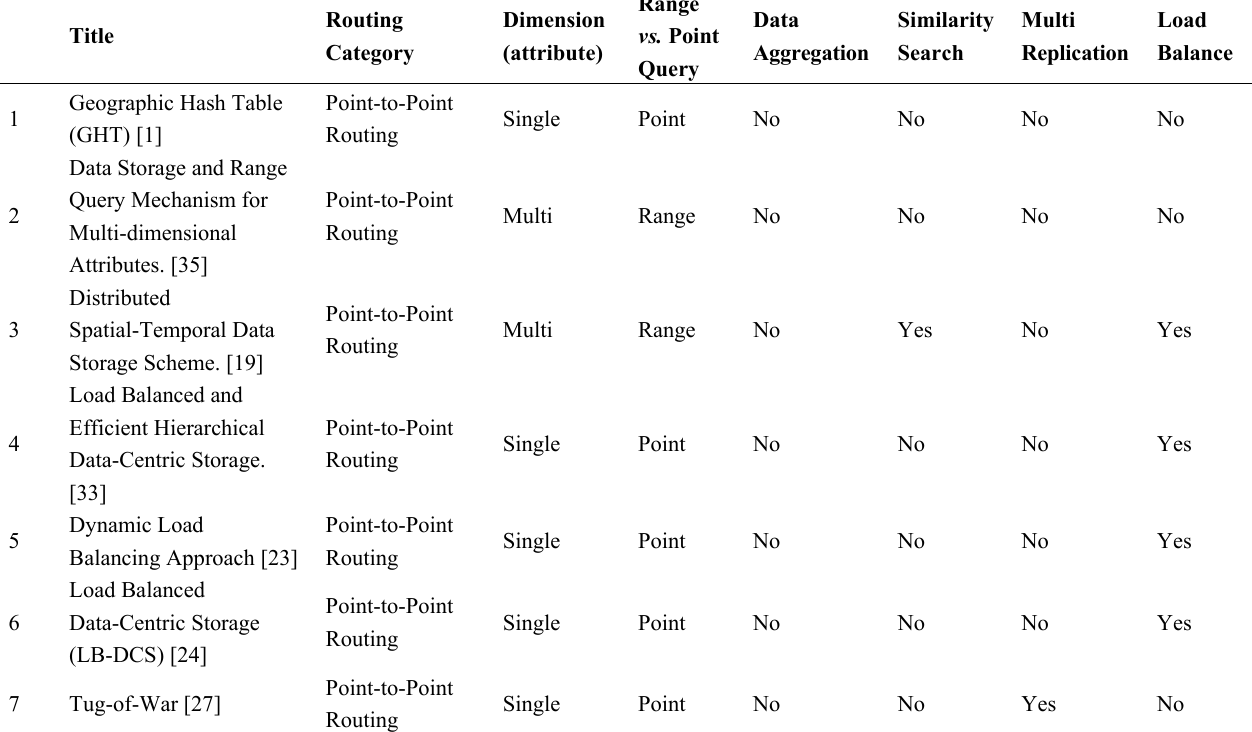
Table 6. Summary of DCS Schemes Highlighting Their Key